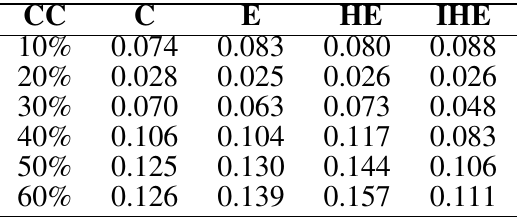
Table 1. RMSE for Sentinel-2 BOA reflectance versus reflectance simulated using a virtual forest created based on each canopy shape and CC. (C:Cylinder, E:Ellipsoid, HE: Half-Ellipsoid and IHE: Inverted Half-Ellipsoid)